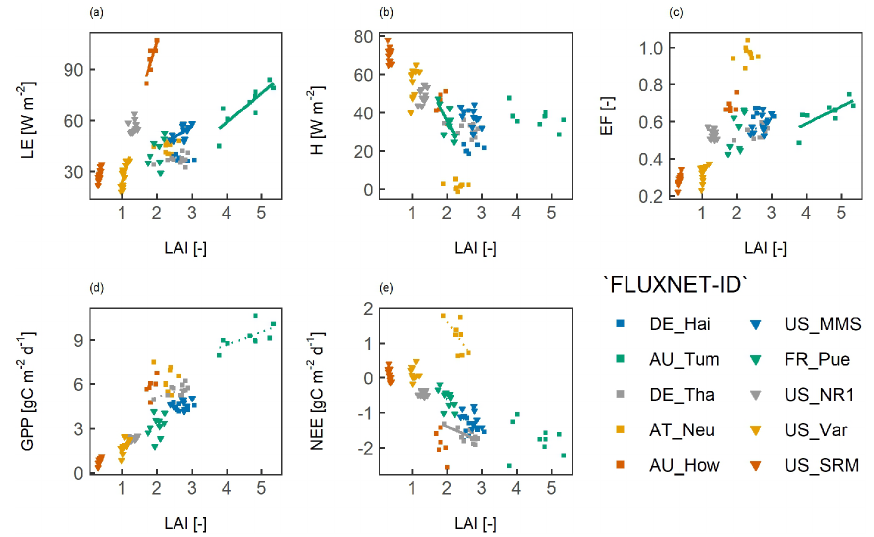
Figure 6. An illustration of the temporal correlation between the yearly average surface fluxes and the leaf area index (LAI). For each land cover type, two sites were selected that had the highest number of available data. The colours of the symbols indicate the land cover type as shown in Figs. 4 and 5. Panels show (a) the latent heat flux ( LE ), (b) the sensible heat flux ( H ), (c) the evaporative fraction (EF), (d) gross primary productivity (GPP), and (e) net ecosystem exchange (NEE). A line indicates a significant correlation at p< 0 . 05, and a dashed line indicates a significant correlation at p< 0 . 1.